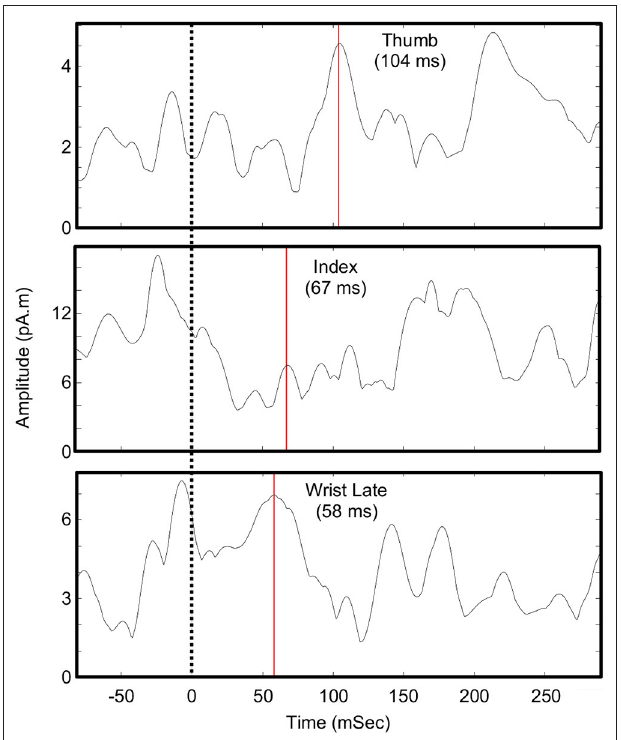
FIGURE 2 | Waveforms for motor evoked fields. Shown is the maximum current density in the pre-central gyrus ROI around the hand knob. Times of source analysis are indicated by the red line. The zero-time point is when a button was pressed by an experimenter (for thumb and index) or released by the participant (wrist).